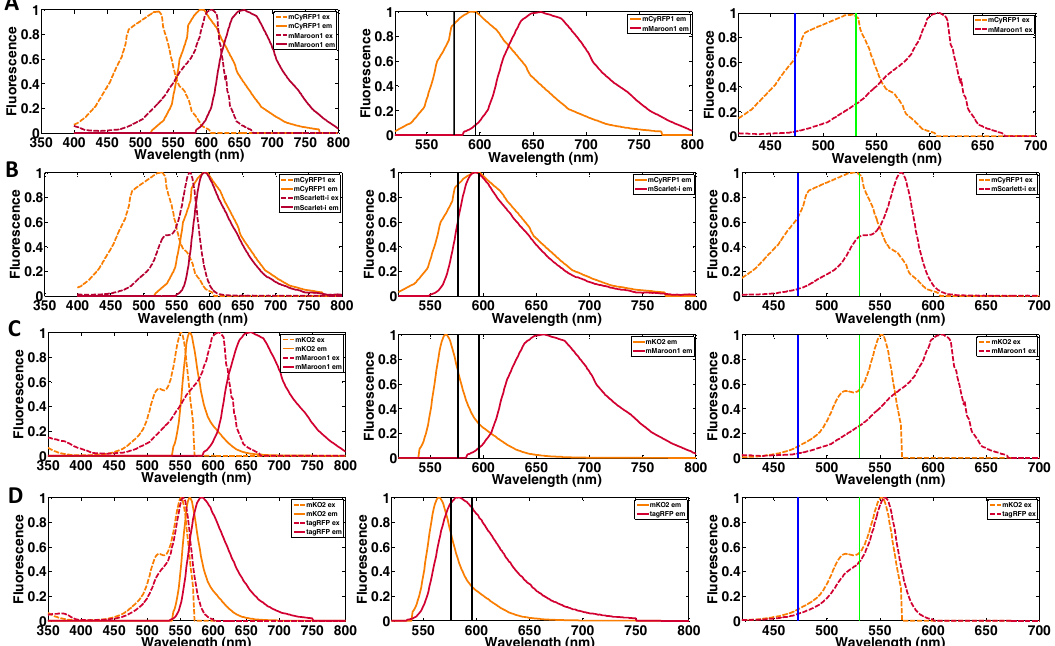
Figure A1. Red-shifted fluorescent protein FRET pairs. ( A ) mCyRFP1/mMaroon, ( B ) mCyRFP1/mScarlett-i, ( C ) mKO2/mMaroon, ( D ) mKO2/tagRFP. The excitation spectra and emission spectra of each donor and acceptor fluorescent protein are shown in right figure for each FRET pair. A 586/20 fluorescence emission band pass filter is shown between black bars in middle figure for each FRET pair. This band pass filter should be optimal for detection of the donor lifetime without interference from the acceptor. The left figure shown for each FRET pair depicts the excitation spectra with the blue line indicating 473 nm laser excitation and the green line 532 nm laser excitation.